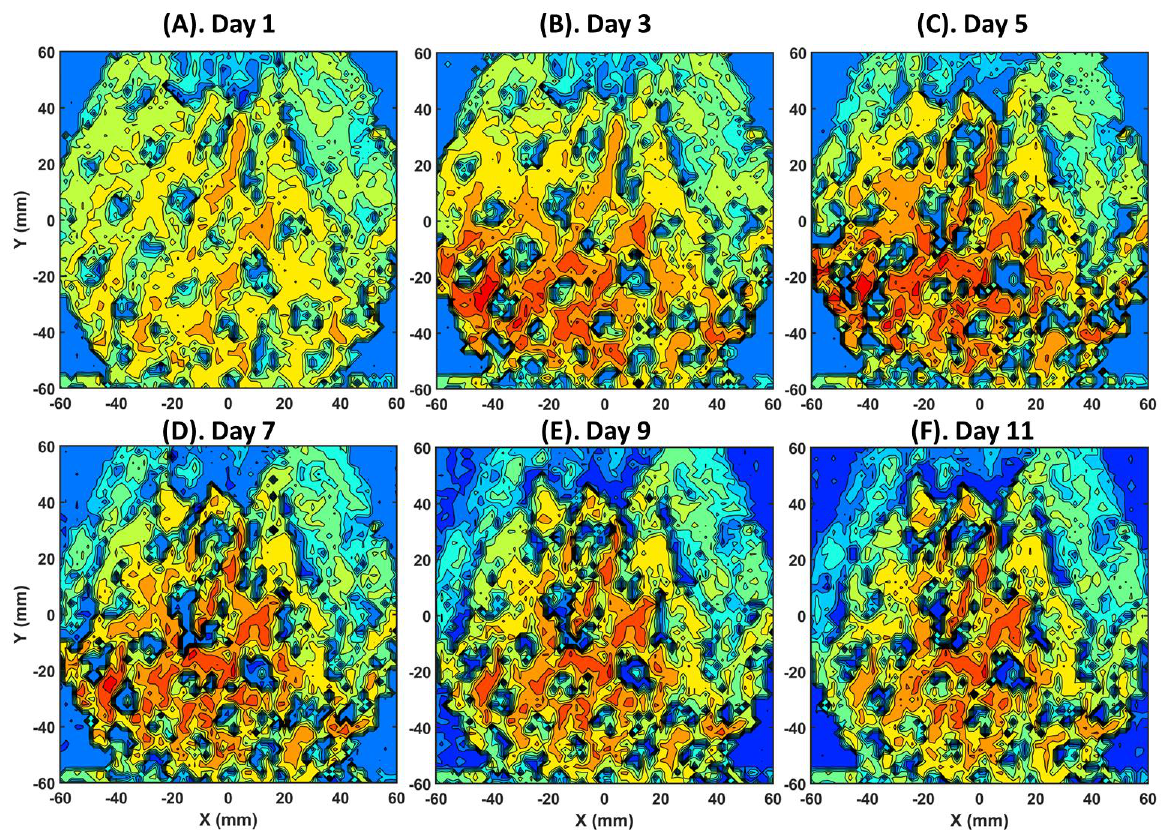
(Figure 3E) to day 1 (Figure 3F), the difference between the elastographic images became more indistinguishable, which indicated a decrease in the rate of tissue degradation.